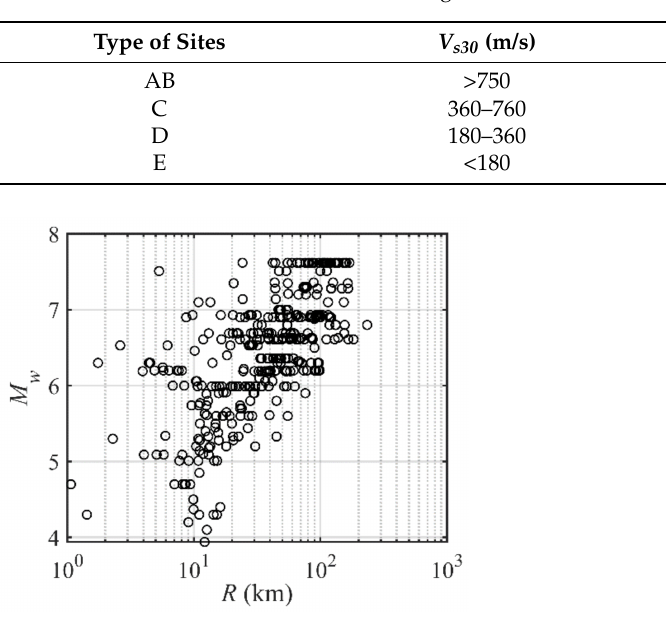
Table 1. Classification site results of selected ground motions.